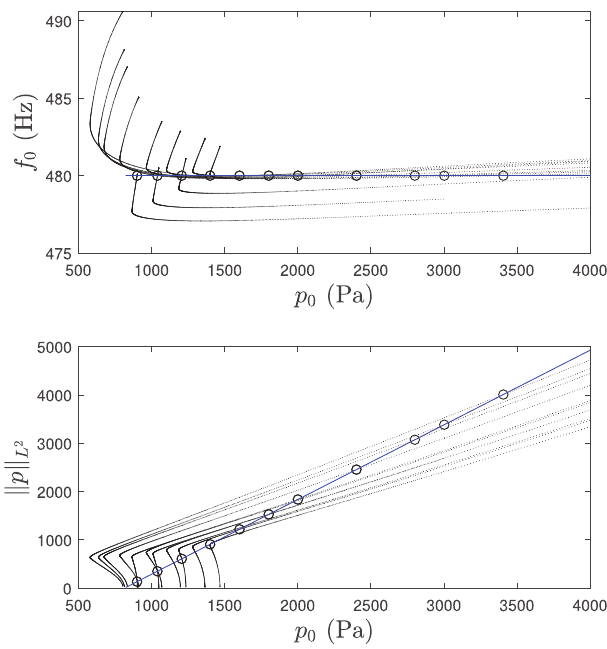
Figure 13. Bifurcation diagram with constraints (blue), over- lapped with constant-parameter bifurcation diagrams where f and Q l are set to values obtained from constrained continuation. Circle markers indicate intersection points between the diagram with constraints and the constant-parameters